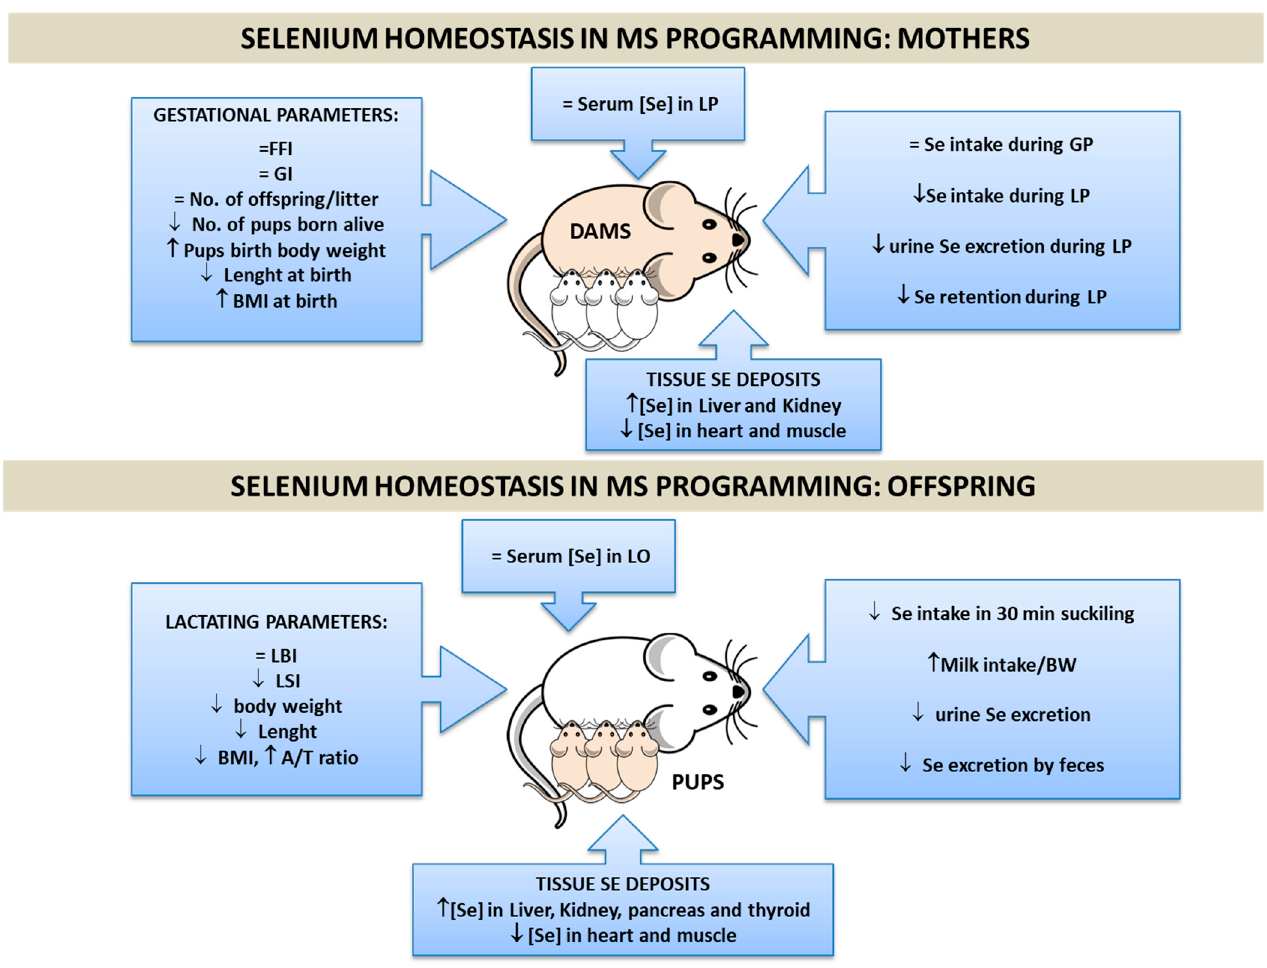
Figure 4. Selenium homeostasis in MetS programming: results in dams and in their offspring. Se intake, excretion, serum concentration, and tissue deposits were analyzed in dams (during gestation process: GP and lactation process: LP) and in their breastfeeding pups (lactating offspring: LO); together with gestational parameters (FFI: female fertility index (nº of pregnancies/nº of mating) × 100, GI: gestational index (nº of successful births/nº of pregnancy rats) × 100) and lactating parameters (LBI: live-born index (nº of pups born alive/nº of pups born) × 10, LSI: lactation survival index (nº of total offspring/nº of dead offspring/nº of total offspring) × 100, and A/T ratio: (ab- dominal circumference/thoracic circumference) × 100), ↑ : increase, ↓ : decrease.